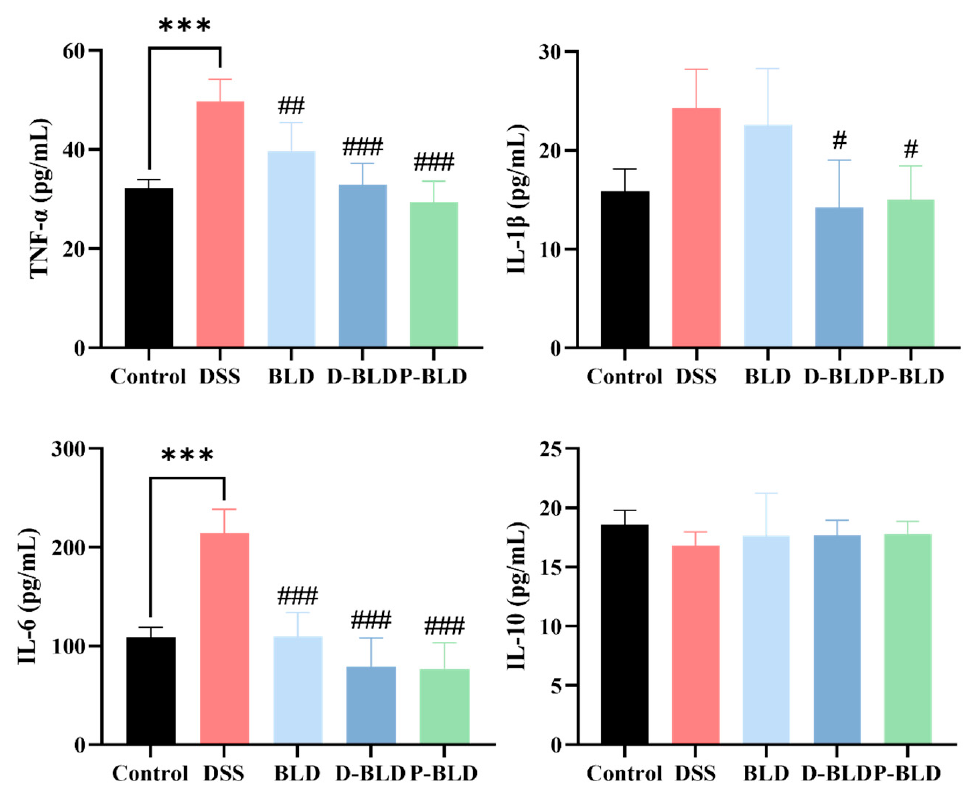
Figure 4. Effect of S. boulardii and its postbiotic elements on serum inflammatory factors in mice with DSS-induced colitis. Note: Data are expressed as mean ± SD. Comparison of significant differences between groups is indicated, where *** p < 0.001 compared with Control group; # p < 0.05, ## p < 0.01, ### p < 0.001 compared with DSS group.